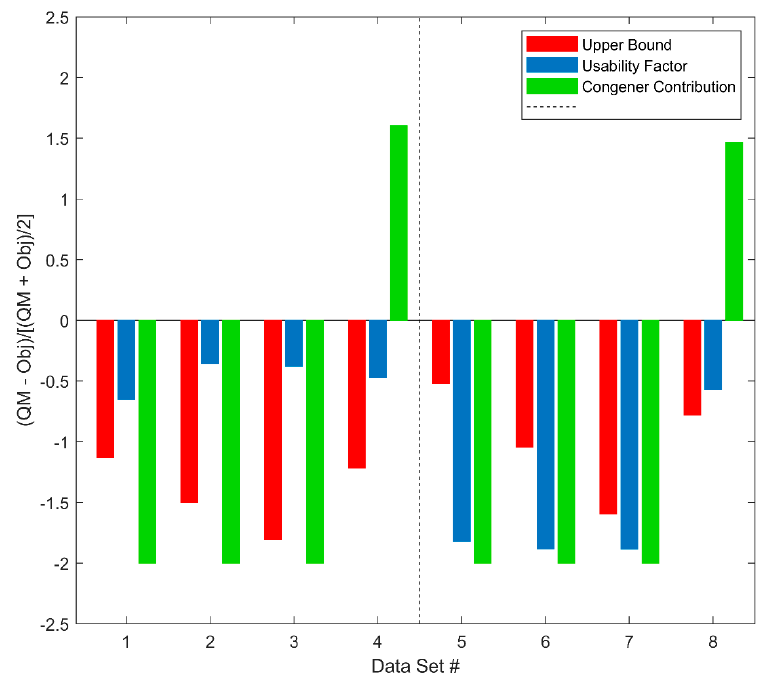
Figure 7. Difference between quality metrics and their objectives for upper bound (red bars), usability factor (blue bars), and congener contribution (green bars) are shown for four pairs of Target Data (left panel) and Duplicate Data (right panel). The x axis gives the order of the eight data sets. The eight datasets are from the whole milk tested on 29 June 2018. Datasets 1 and 5 are the detections of dioxins and furans; 2 and 6 are detections of mono PCBs; 3 and 7 are detections of marker PCBs, and 4 and 8 are detections of PBDEs. #: Data Set. Int. J. Environ. Res. Public Health 2019 , 16 , x